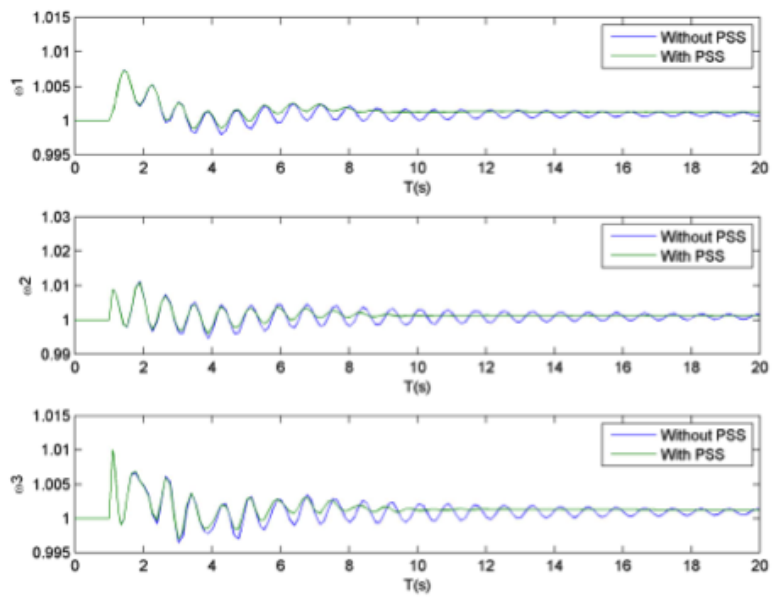
Figure 8. Response of the machine velocity of the three-machine—nine-busbar IEEE system when a fault occurs at busbar 4, with PSS and without PSS. Angular velocities ω 1, ω 2, ω 3 are shown in dependence of time T in seconds.